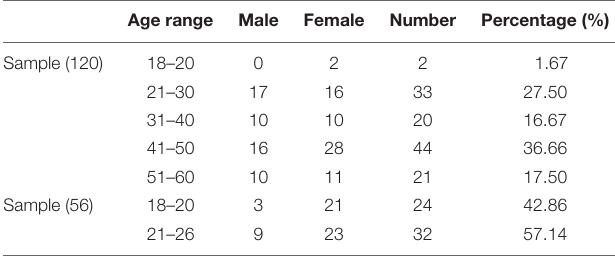
TABLE 1 | Descriptive statistics for the demographic characteristics of the two